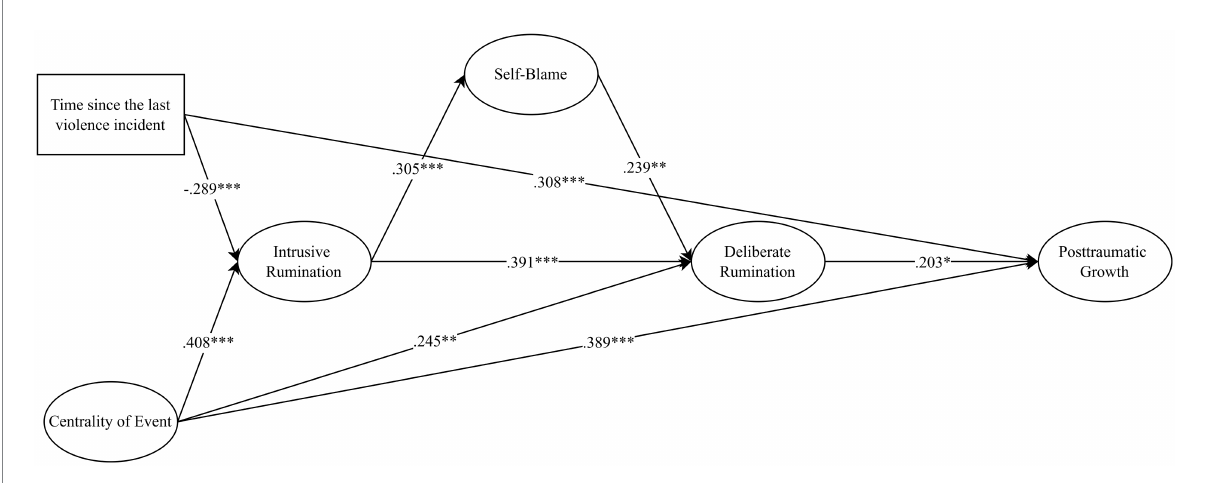
FIGURE 1 Structural equation model predicting post-traumatic growth. Only significant paths are indicated. Statistics are standardized